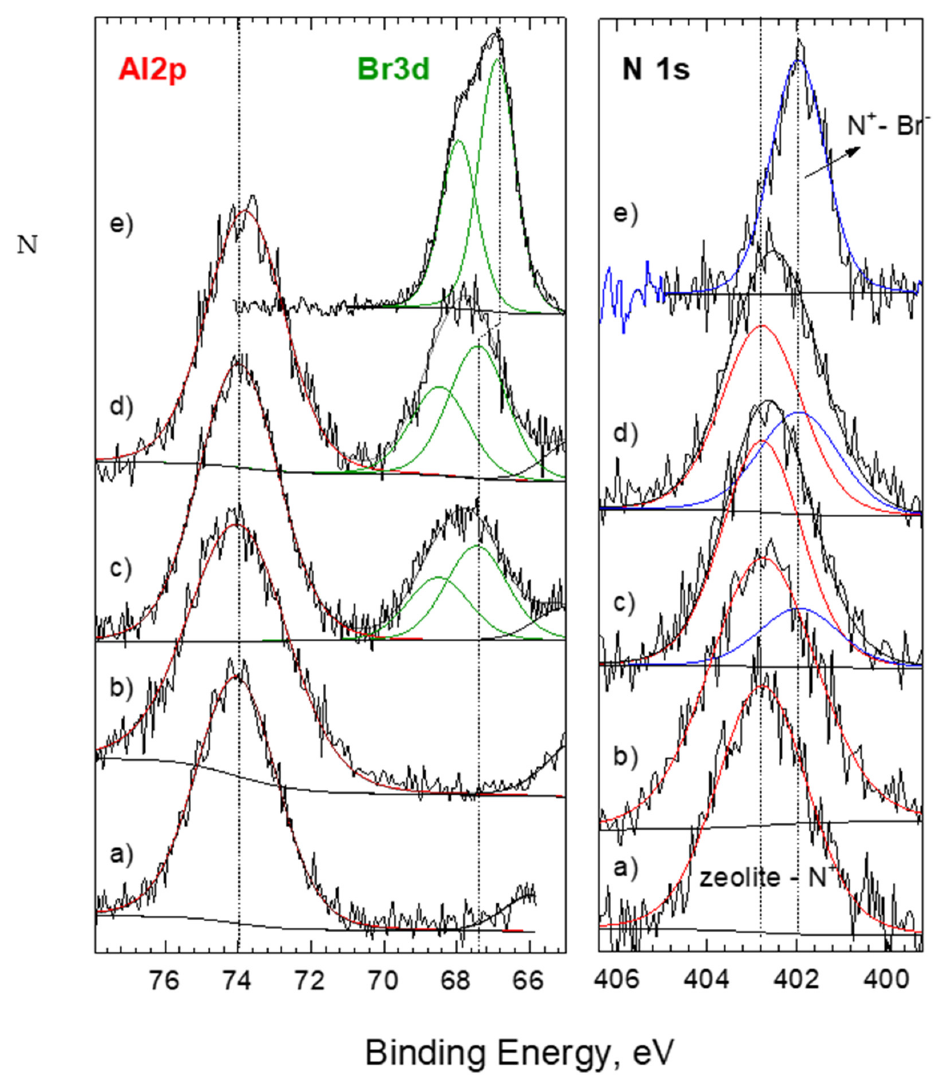
Figure 6. XPS N 1s and Al2p&Br3d spectra for ( a ) CH-HDTMA 1.0 ECEC, ( b ) CL-HDTMA 1.0 ECEC, ( c ) CH-HDTMA 2.0 ECEC, ( d ) CL-HDTMA 2.0 ECEC, and ( e ) HDTMA as a reference.